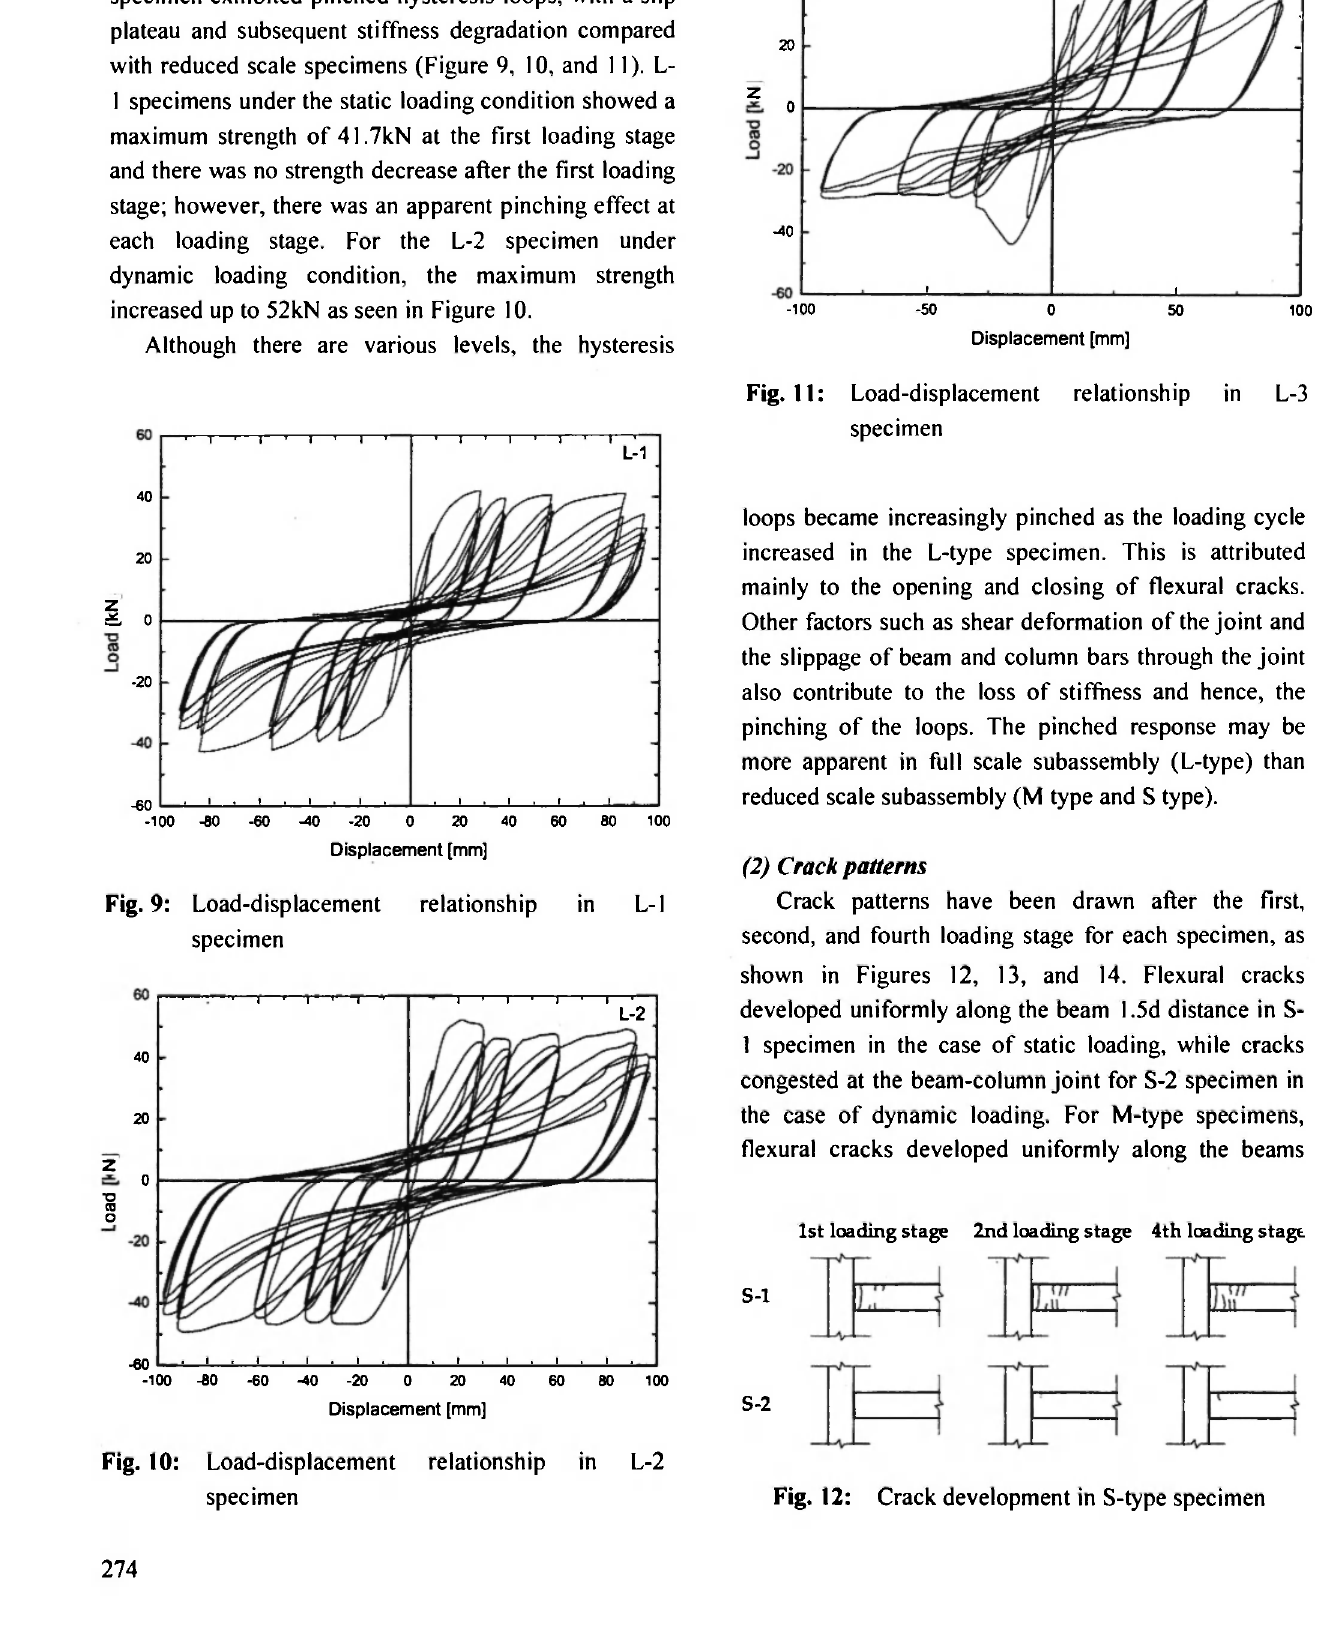
Fig. 10: Load-displacement relationship in L-2 specimen